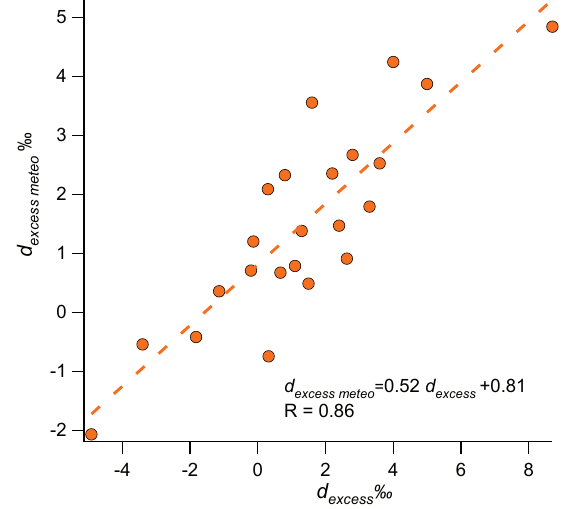
Figure 6. Correlation between monthly mean deuterium excess values ( d excess ) from precipitation samples and theoretical deu- terium excess values ( d excess meteo ) calculated from meteorologi- cal parameters of the moisture source region according to Uemura et al. (2008).